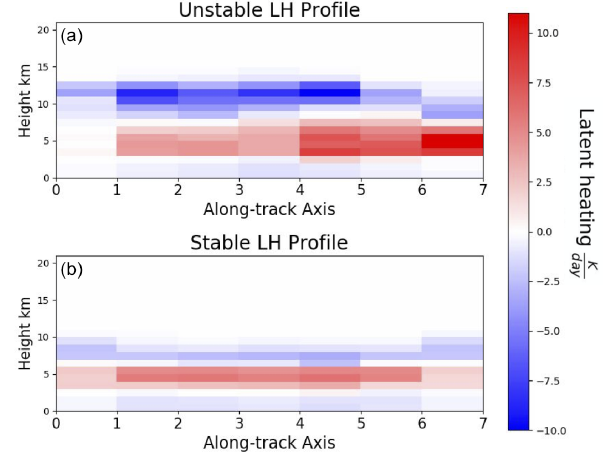
Figure 1. An example of the latent heating profiles for clouds in unstable (a) and stable (b) environments with a 7km rain system size from warm cloud systems over the Pacific in January